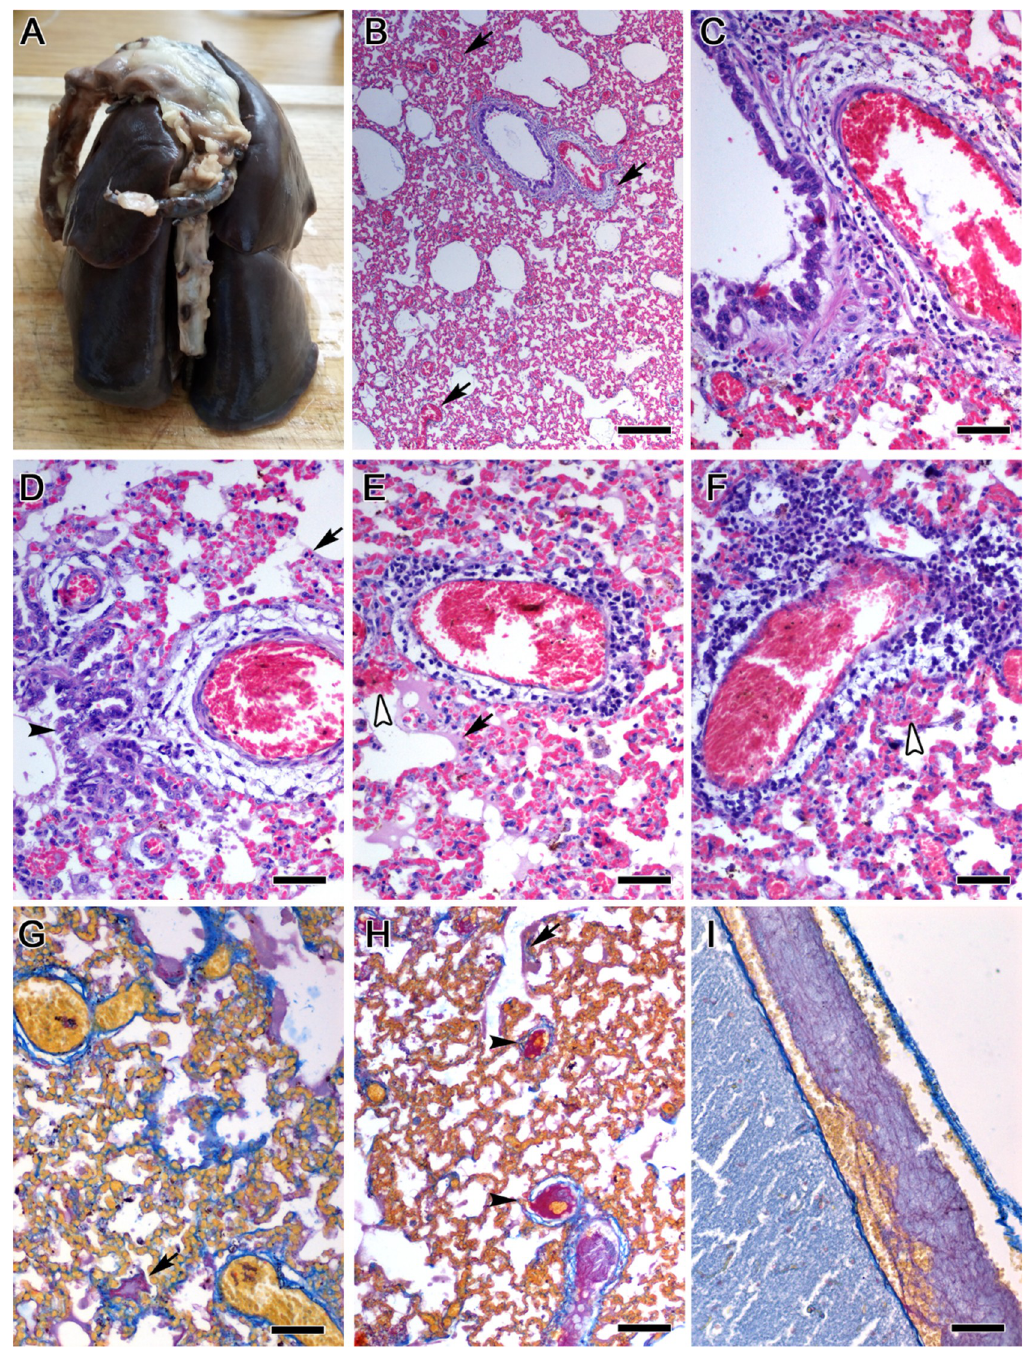
Fig 6. Characteristic pathological findings of SARS-CoV-2 infection in minks. (A) Formalin-fixed lung. Evidence of bilateral acute pneumonia. All lung lobes are dark brown-red in color and mildly enlarged. (B) Low-power magnification view of representative lung tissue histopathology uniformly observed. Diffuse hyperemia with vascular wall loss (arrows) and bronchus epithelium damage. (C) Part of the previous image is shown in high-power magnification to highlight vascular endothelial lining and wall destruction and edema. There is sub-epithelial edema in bronchial epithelium and degeneration and necrosis of epithelial cells. (D-F) Spectrum of inflammatory cell cuffing in damaged lung parenchymal vessels. Increasing severity of inflammatory cell infiltrate within and around the vessels from left to the right panel. Lymphocytes, plasma cells and macrophages infiltrate primarily the area of medial and external tunics that are edematous and contain necrotic cells and tissue debris. Note bronchiolar epithelial cell degeneration and necrosis (black arrow-head in D), hyaline membranes (arrows in E